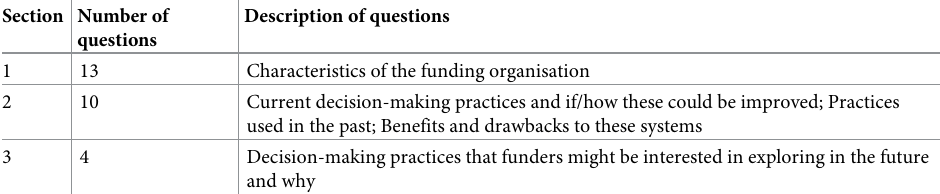
Table 1. Description of contents of each of the three survey